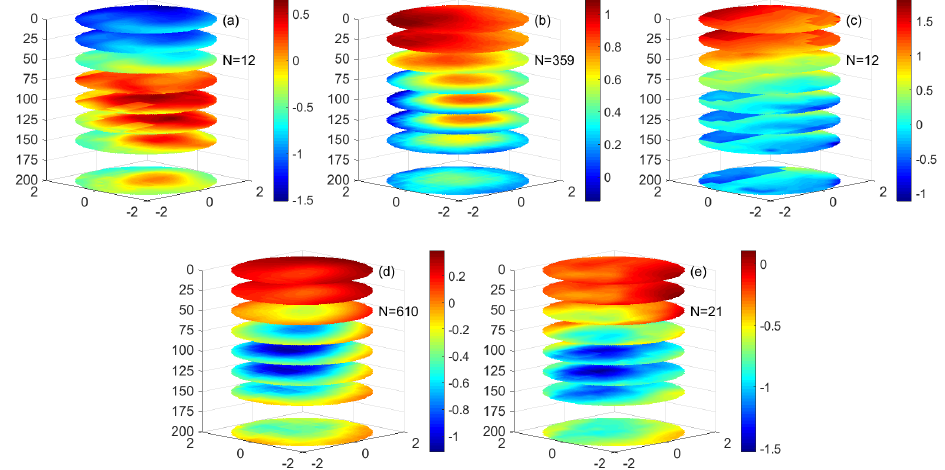
Figure 12. The three−dimensional structure of temperature anomalies in a different eddy. ( a − e ) are ( a ) mode-water eddies, ( b ) low nonlinear anticyclonic eddies, ( c ) high nonlinear anticyclonic eddies, ( d ) low nonlinear cyclonic eddies, and ( e ) high nonlinear cyclonic eddies. (Unit: °C).